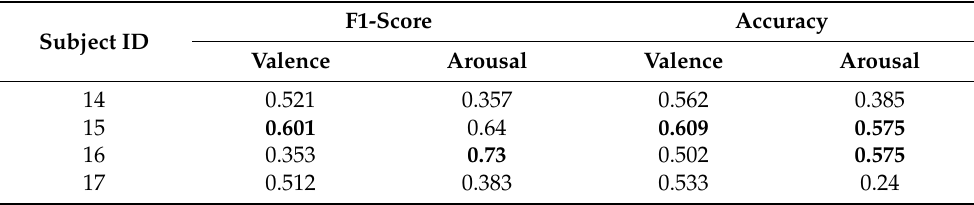
Table 5. F1-Score and accuracy for the live affect classification (Dataset III, part 2). Subjects 14 and 17 wore Muse, while subjects 15 and 16 wore the Crown for data collection. The highest scores across all participants for each evaluation matrix are marked in